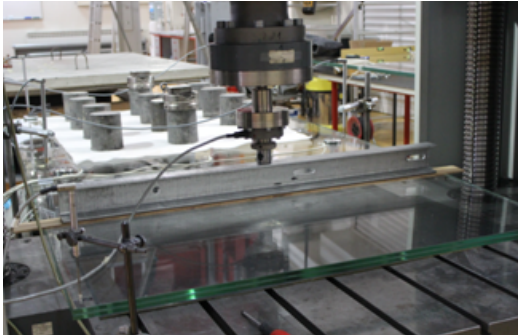
Figure 5. Load bearing capacity test.